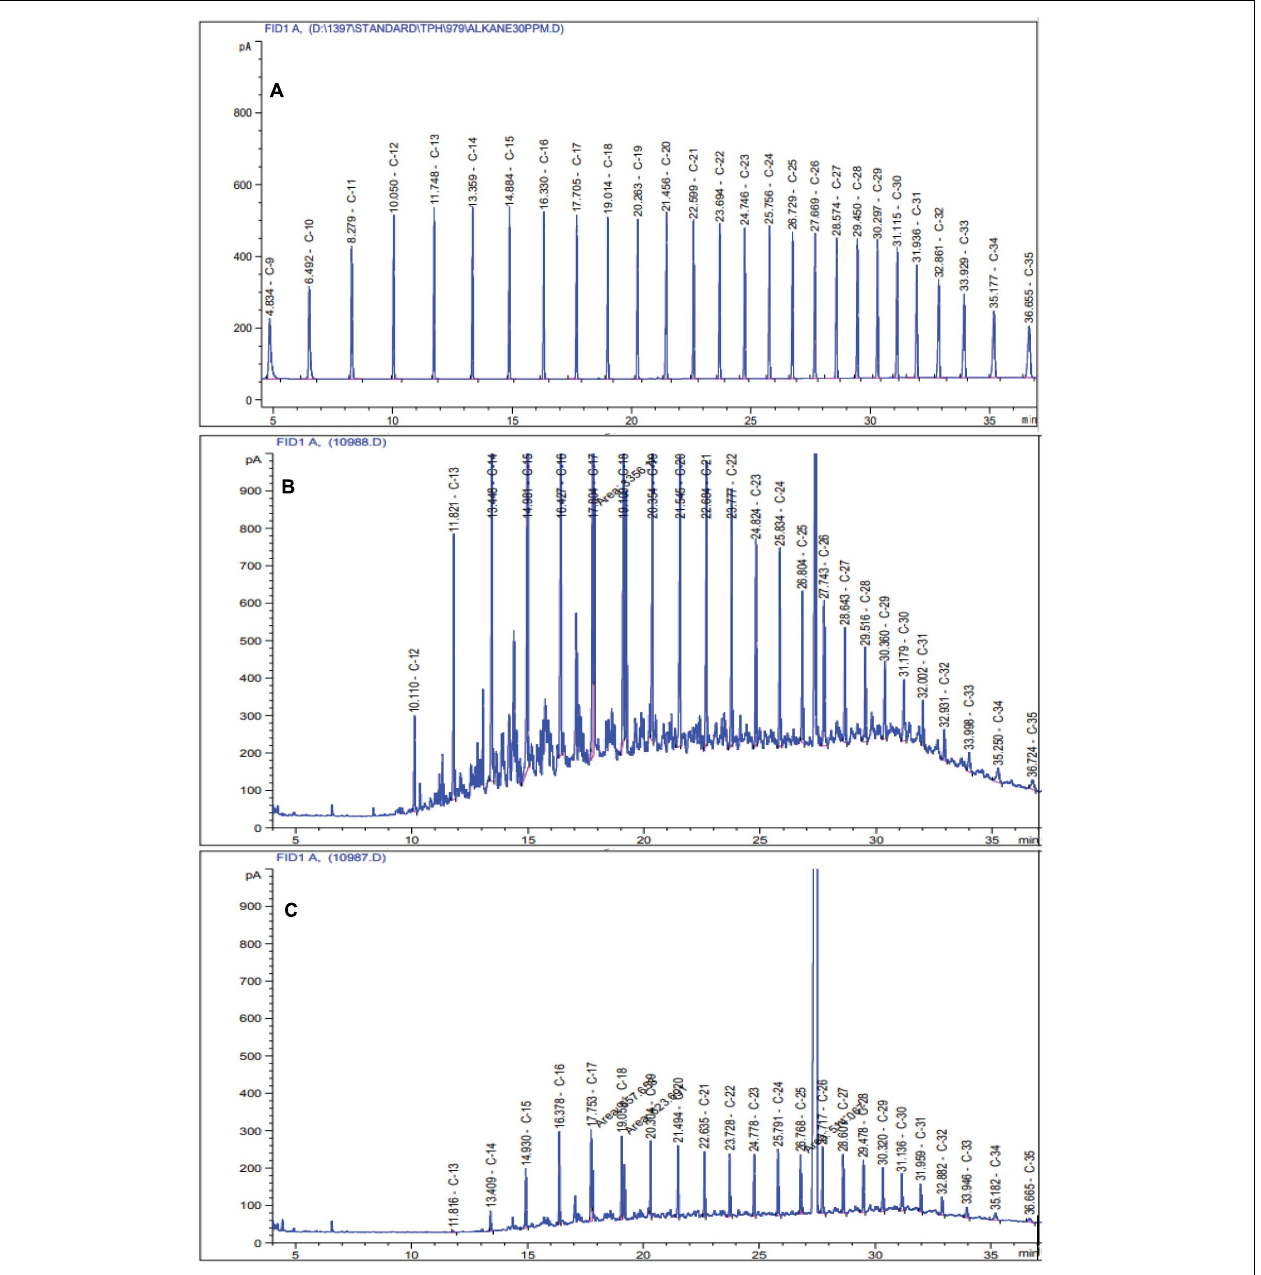
FIGURE 1 | Chromatograms of residual TPH in the modified 6SW-Vit medium after 7 days of incubation at 40 ◦ C temperature. (A) standard mix solution of TPH, (B) non-biodegraded control, and (C) biodegraded